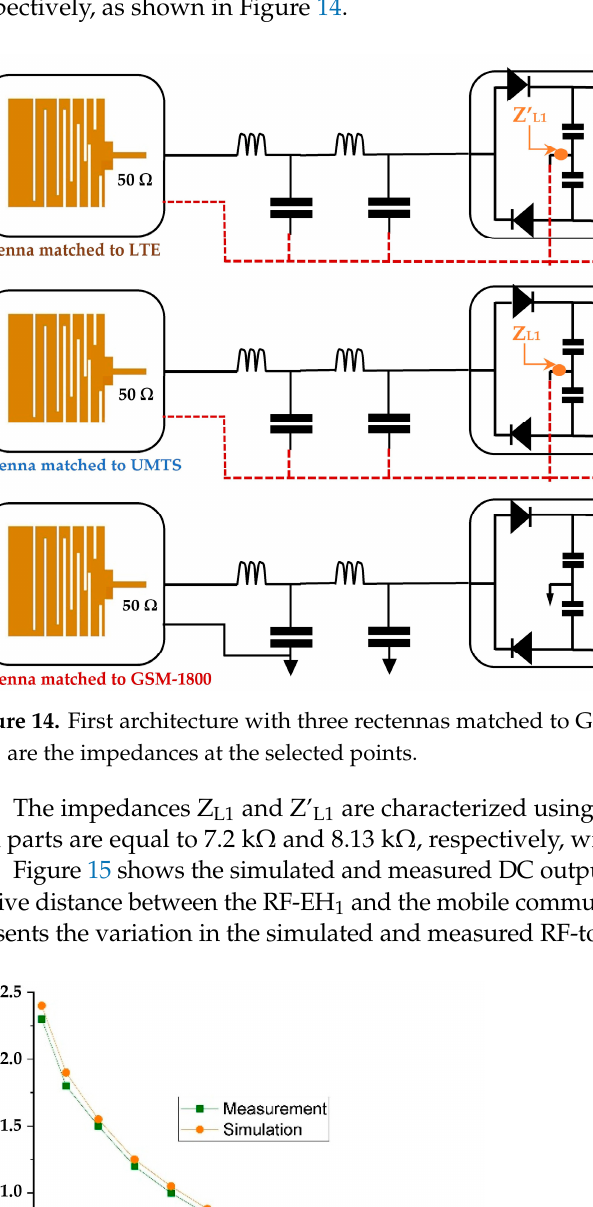
Figure 16. Simulated and measured RF ‐ to ‐ DC conversion efficiency for 2 k Ω resistance load. The maximum simulated and measured efficiencies of 71.5% and 71% are achieved at 72 m from the mobile communication relay antenna. These efficiencies stay above 50% until 122 m. The measured DC power supplied by this architecture is 288.8 μ W at the effective distance of 72 m and 39.2 μ W at 122 m. These results demonstrate that this architecture is suitable for low input powers (far distances from relay antenna) and limited for high input powers (near to relay antenna). Figure 17 shows the realized RF ‐ EH 1 with a dimension of 64 × 55 mm 2 . Figure 17. ( a ) Realized RF ‐ EH1 based on the first architecture, ( b ) Measurement prototype at 22 m from relay antenna .